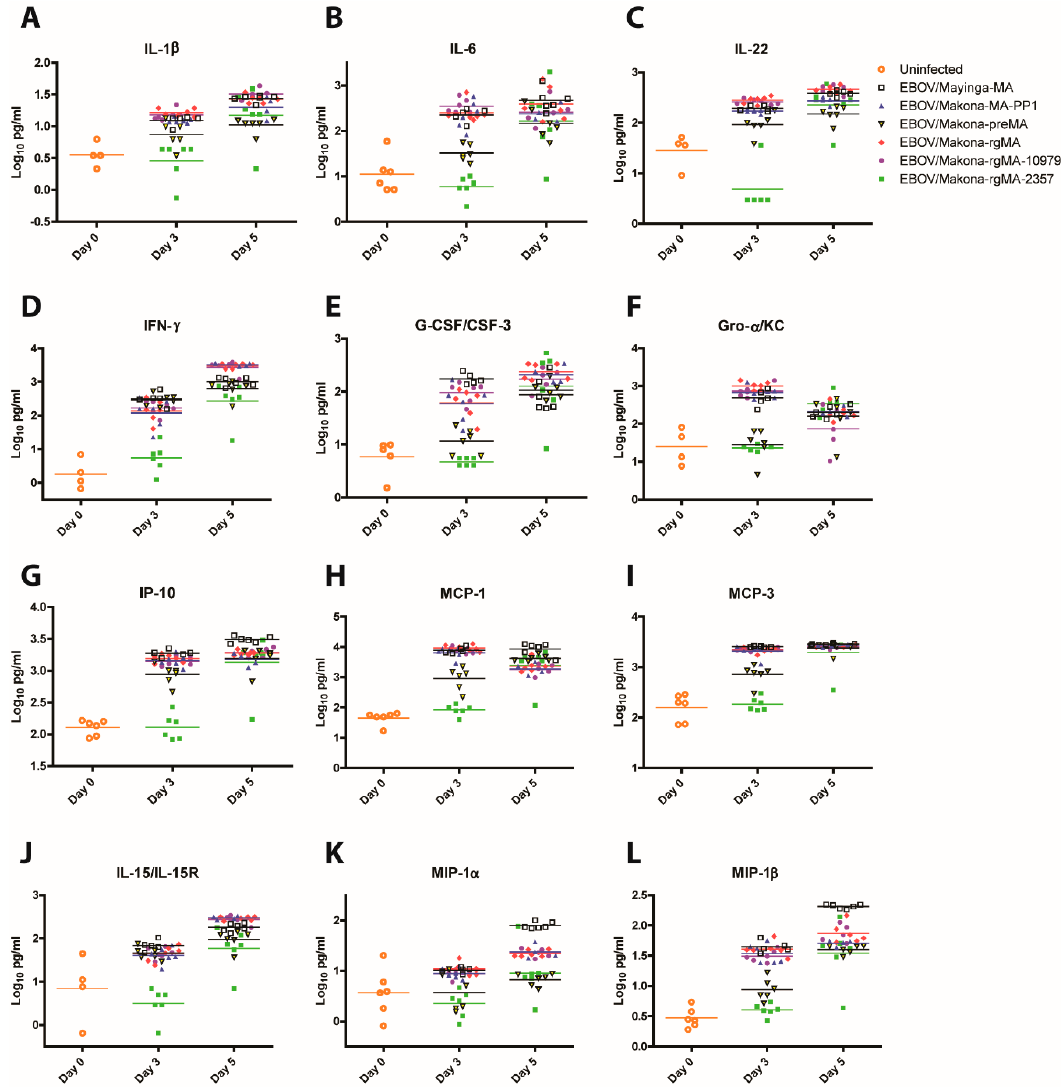
Figure 4. Cytokine and chemokine responses in mice that were infected with MA-EBOV. Groups of mice ( n = 6) were infected intraperitoneally with 10 PFU of either EBOV / Mayinga-MA, EBOV / Makona-MA-PP1, EBOV / Makona-preMA, EBOV / Makona-rgMA, or the two single mutant viruses EBOV / Makona-rgMA-10979 or EBOV / Makona-rgMA-2357. Serum samples were collected on days 3 and 5 post-infection and expression levels of ( A ) IL1- β , ( B ) IL-6, ( C ) IL-22, ( D ), IFN- γ , ( E ) G-CSF / CSF-3, ( F ) Gro- α / KC, ( G ) IP-10, ( H ) MCP-1, ( I ) MCP-3, ( J ) IL-15 / IL-15R, ( K ) MIP1- α , and ( L ) MIP-1 β were determined by Luminex